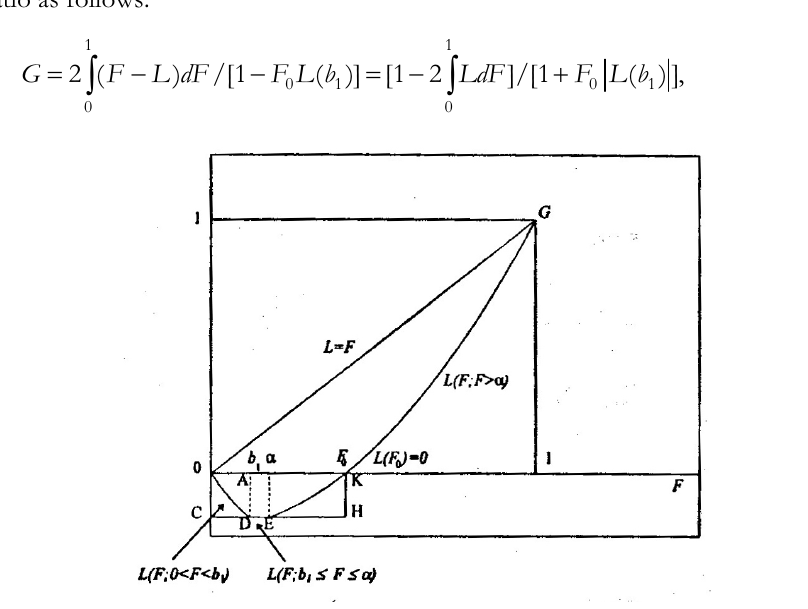
Figure 4 – Lorenz curve